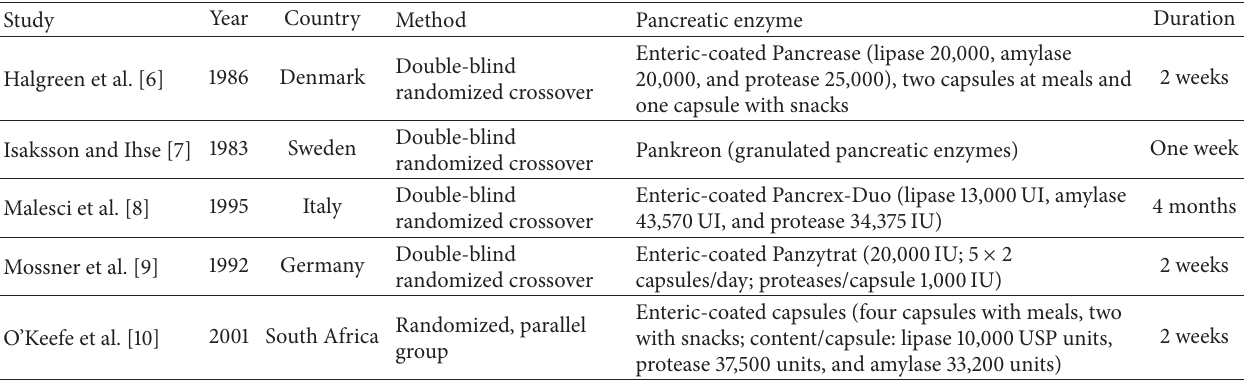
Table 1: Characteristics of five included studies.